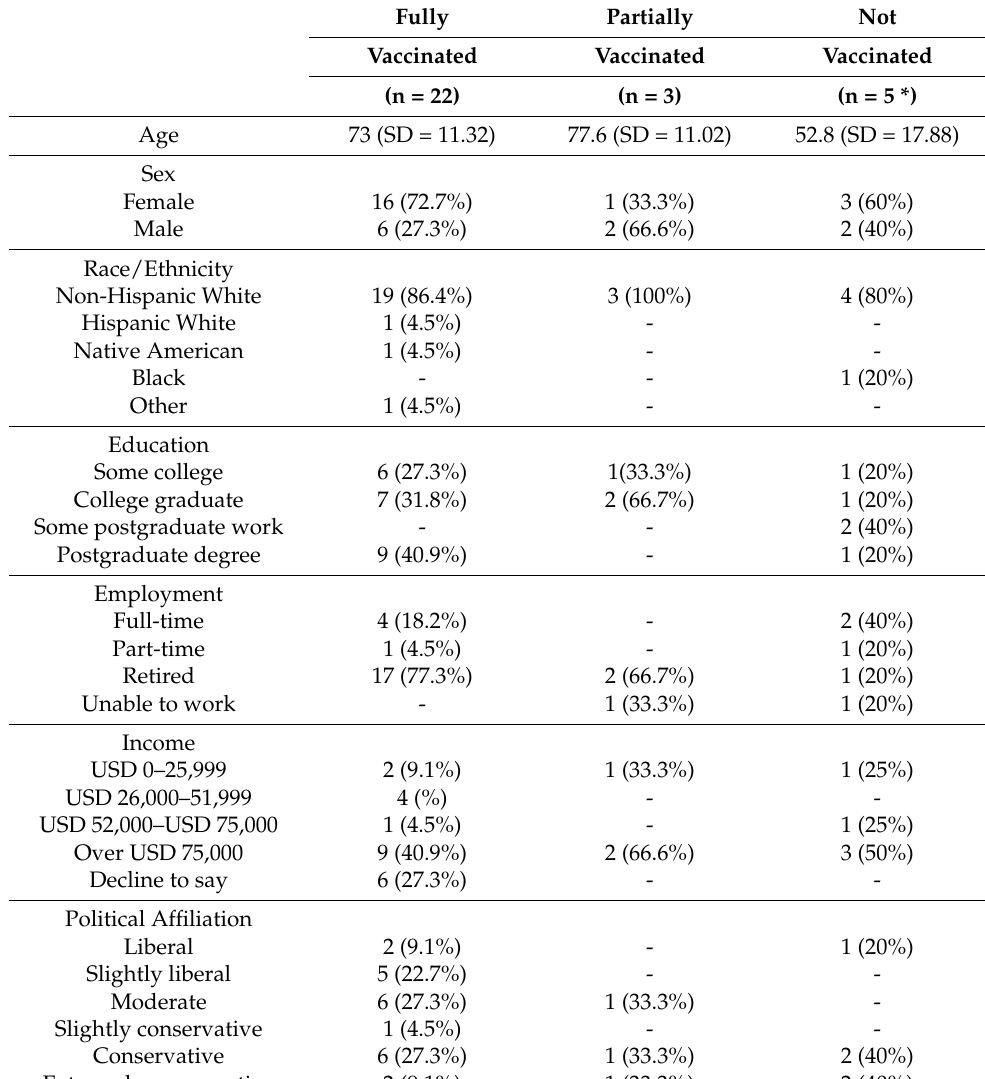
Table 2. Participant demographics by vaccination